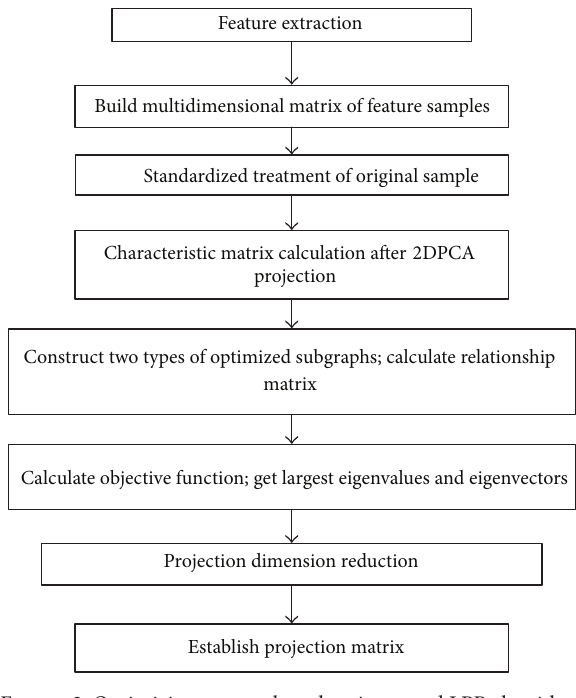
Figure 2: Optimizing process based on improved LPP